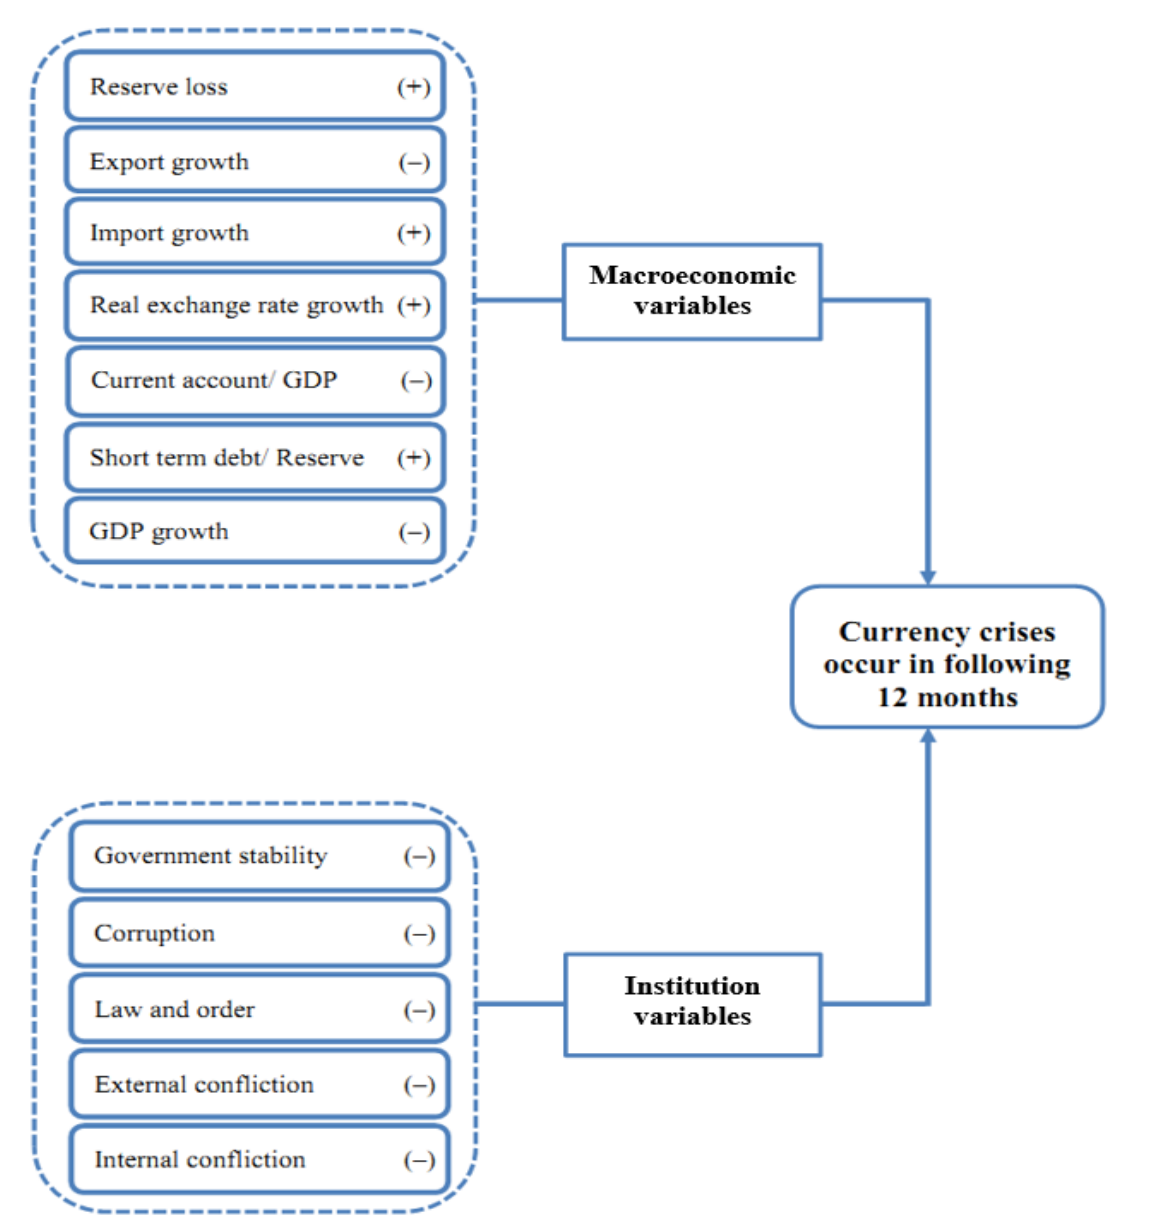
Figure 2. Variable selection for hypotheses development.